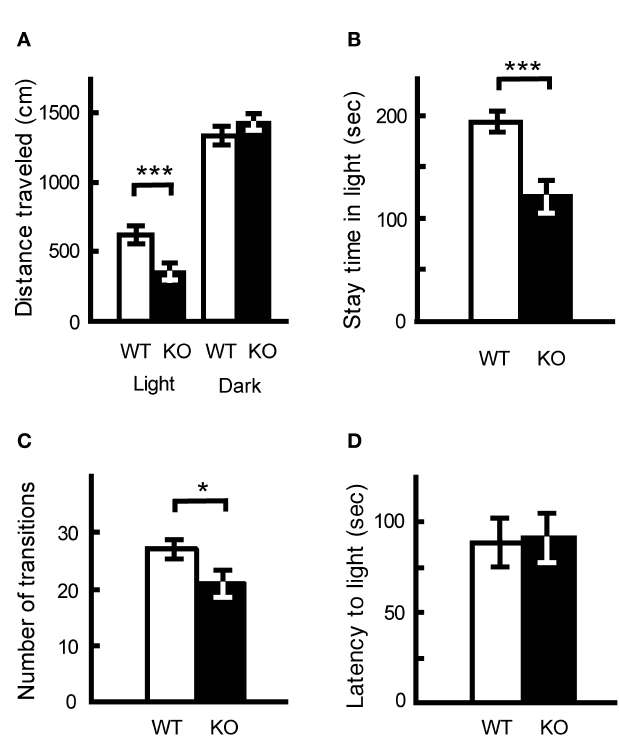
Figure 9 | Increased anxiety-like behavior in kf-1 − / − mice in the light/ dark transition test compared to kf-1 + / + littermates. Mice were placed individually in the dark compartment at the start of the test. Data are given as mean ( ± SEM). (A) Distance traveled (centimeters) in the light and dark sides. (B) Time (seconds) the mice stayed in the light side. (C) Number of transitions between the light and dark sides. (D) Latency time (seconds) before the fi rst entry into the light side. * p < 0.05; *** p < 0.0005 (see Section ‘Light/dark transition test’). WT and KO stand for kf-1 + / + and kf-1 − / − mice, respectively.